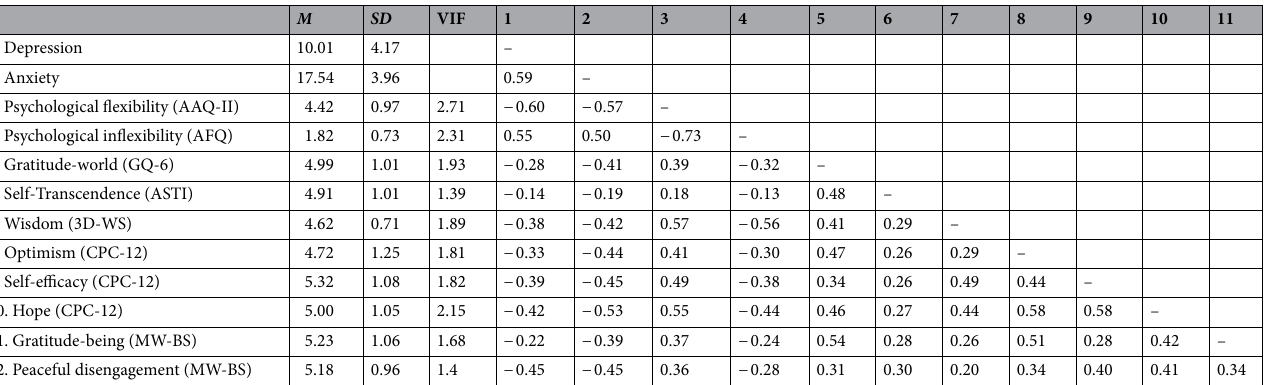
Table 2. Descriptive statistics and correlation matrix of the study variables as measured in wave 1. All correlations are significant at p < 0.001. M mean, SD standard deviation, VIF variance inflation